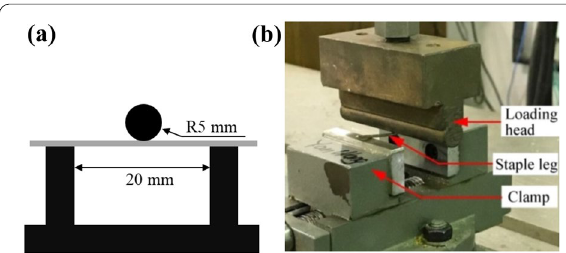
Fig. 7 Setup for evaluating the load–deflection behavior of single legs subjected to a center-loading: a detail dimensions and b actual setup